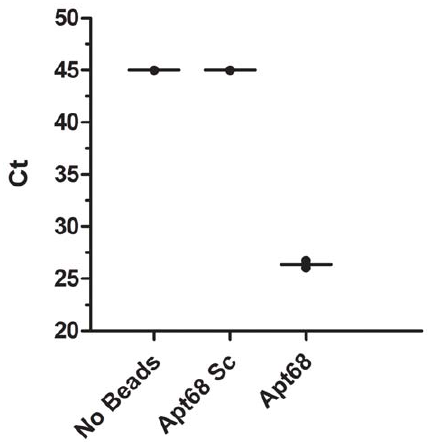
Figure 7. Pull down assay with T.cruzi trypomastigote spiked human whole blood samples. Human whole blood samples (15 ml) spiked with trypomastigotes at a concentration of 0.33 parasites/ml (5 parasite in 15 ml) was subjected to the pull down using Apt68 coated paramagnetic beads as described in the Methods section. The aptamer coated beads were incubated, for 1 hour at room temperature, with the parasite spiked whole blood samples. The parasite-bead aggregates were recovered using a magnetic stand suitable for 15 ml falcon tubes. After 3 washes, with 15 ml SELEX buffer per wash, the bound beads were recovered from the magnet, genomic DNA isolated and amplified in the real time PCR assay. The whole blood pull down assay, using blood from 3 different donors, was repeated in 5 independent experiments and data from a representative experiment is shown. Mean Ct values are plotted on the y-axis with error bars representing the standard deviation of 2 replicate PCR tests. Results showed that when Apt68 was used in the pull down assay, the Ct value was significantly lower than that obtained for samples treated with either the scrambled aptamer (Apt68 Sc) or in the absence of any beads. Based on the negative controls of the real time PCR assay, where only nuclease free water was used as an amplification template, a sample with Ct values higher than 40 cycles was considered as a negative.